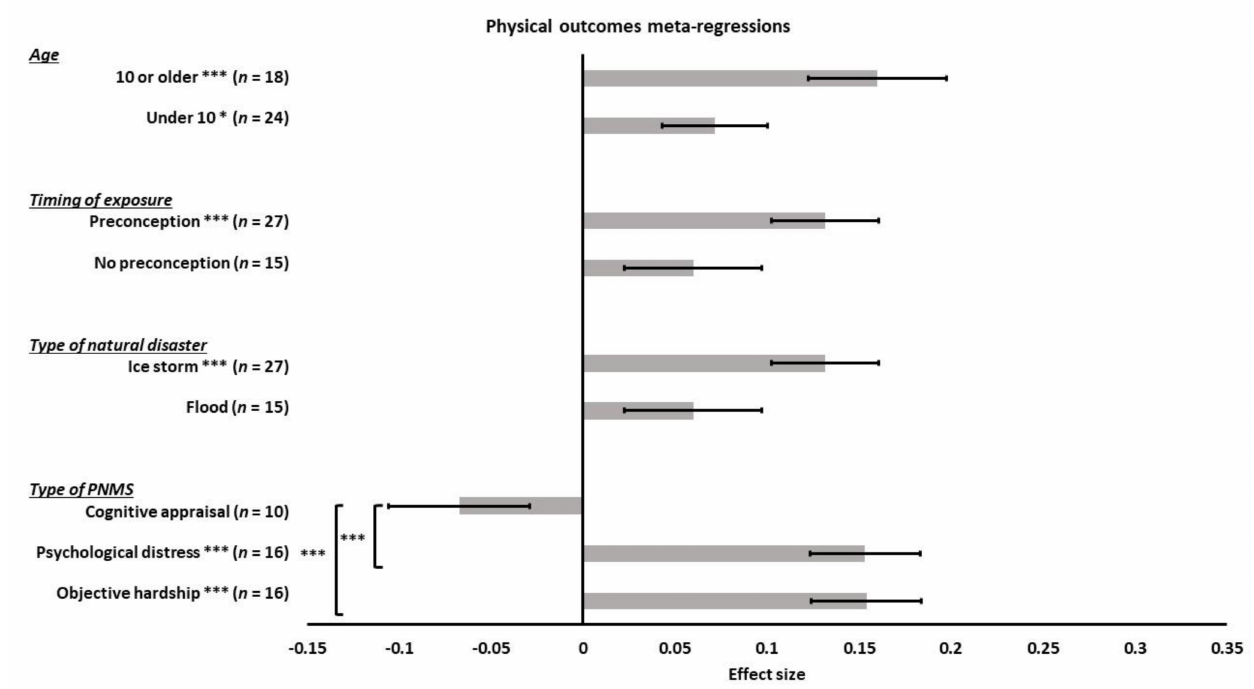
Figure 13. Physical outcomes meta-regressions. Type of PNMS effect (objective hardship; psychological distress; cognitive appraisal) on physical outcomes, type of natural disaster effect (flood; ice storm), timing of exposure effect (no preconception; preconception) and age effect (under 10 or 10 or older) on the association between PNMS levels and physical outcomes. Note: * p < 0.05; *** p <